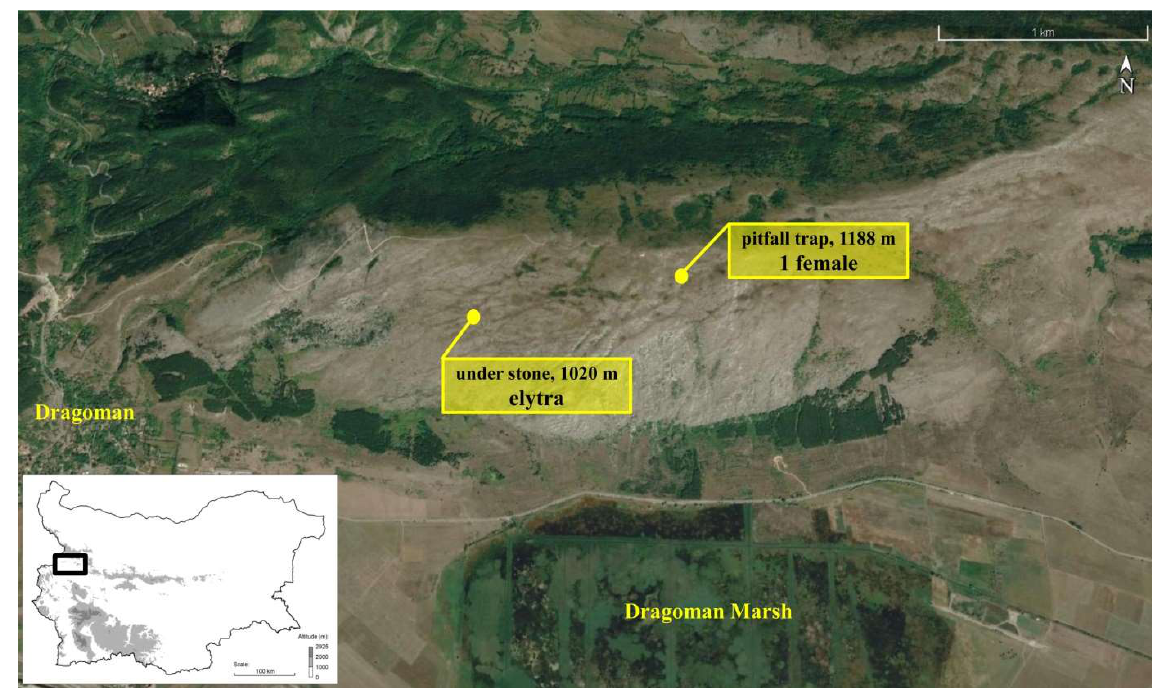
Figure 2. Location of the Chepan Planina Mt. and the two localities where Carabus bessarabicus was found.